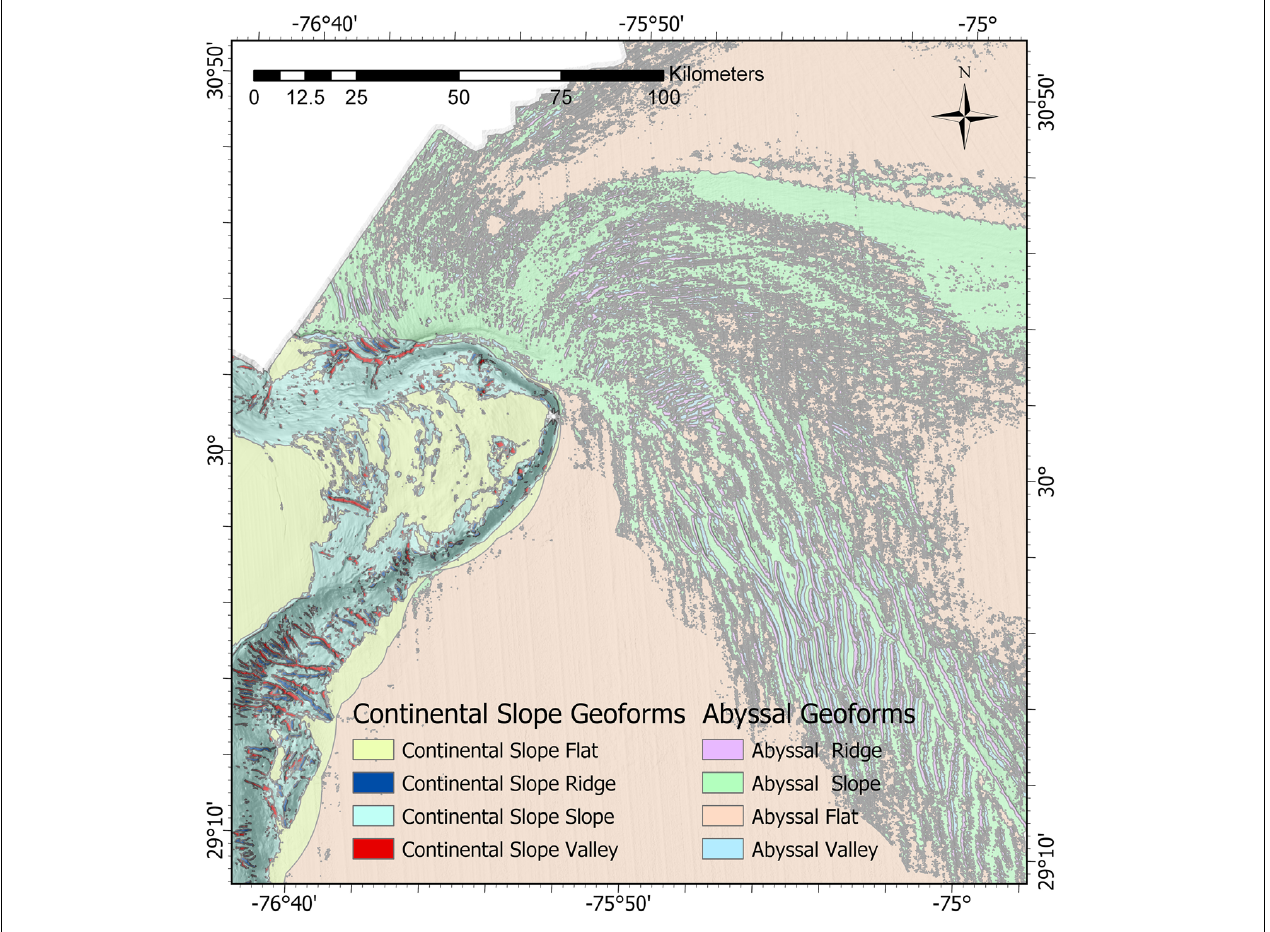
FIGURE 10 | Geoform view of part of the Blake Escarpment and Blake